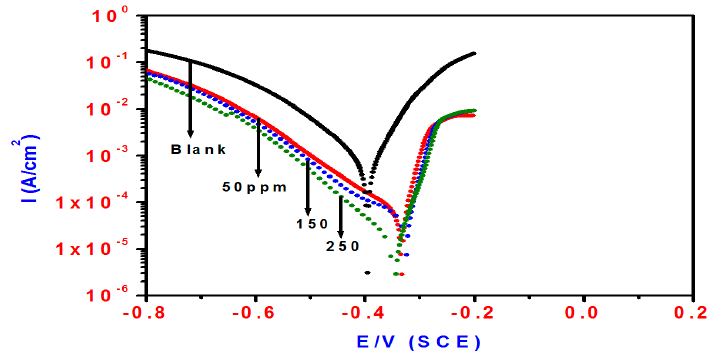
Figure 2. The effect of T3Q concentrations on the polarization curves of steel in acidic chloride solutions.